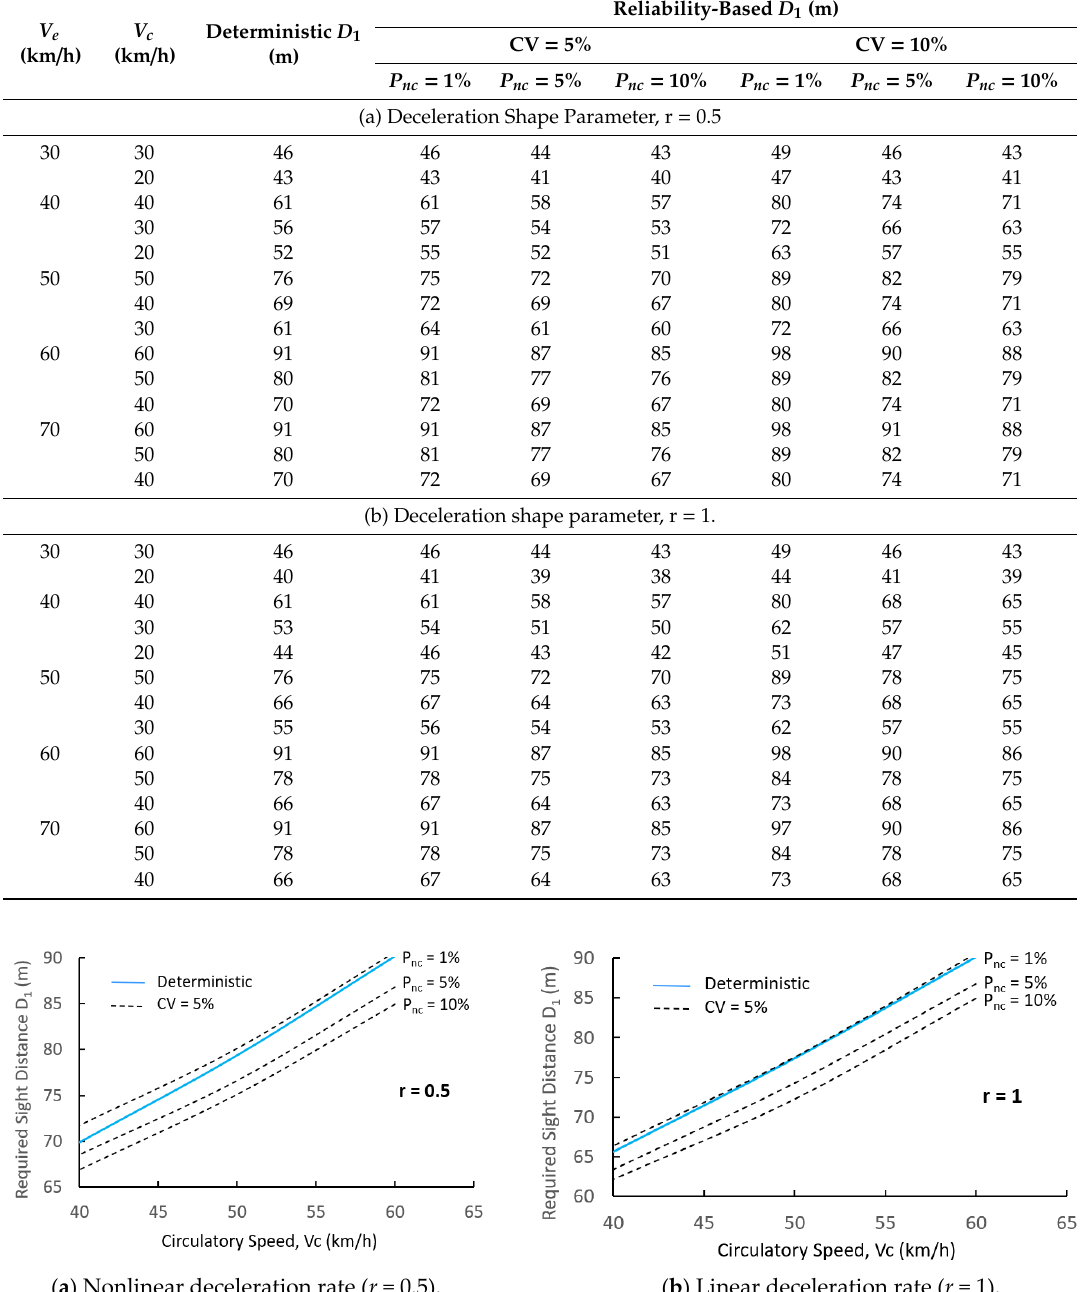
Figure 5. Comparison of the deterministic and reliability-based values of required sight distance D 1 for linear and nonlinear deceleration profiles ( V e = 60 km/h). ( a ) Nonlinear deceleration rate ( r = 0.5). ( b ) Linear deceleration rate ( r = 1).